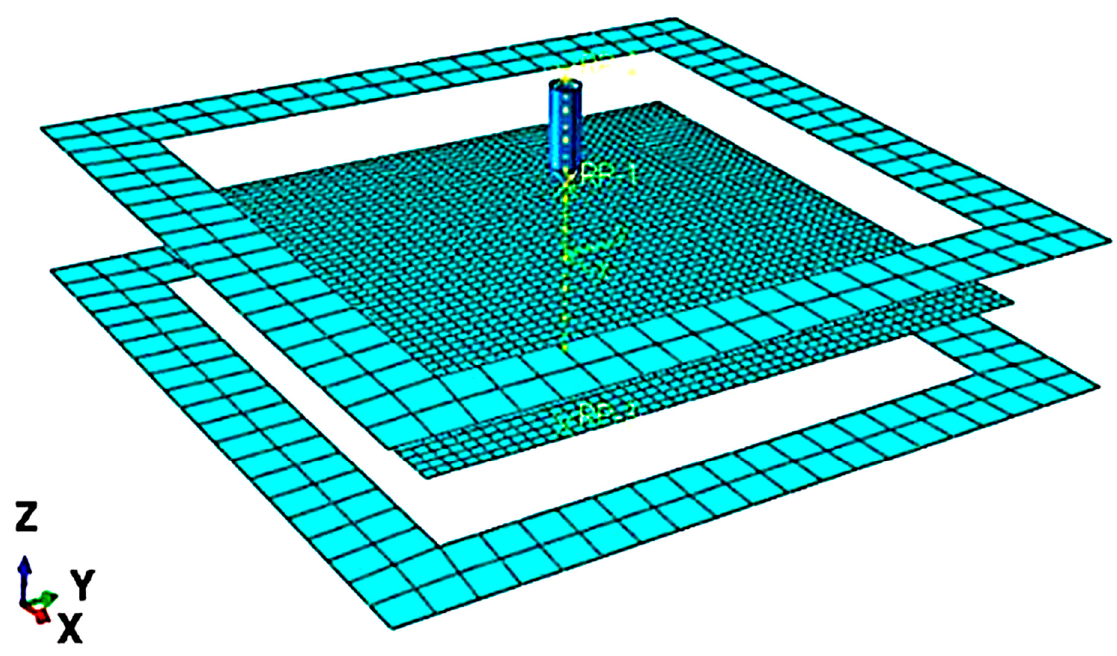
Figure 2. The simulation model of the SPIF process.